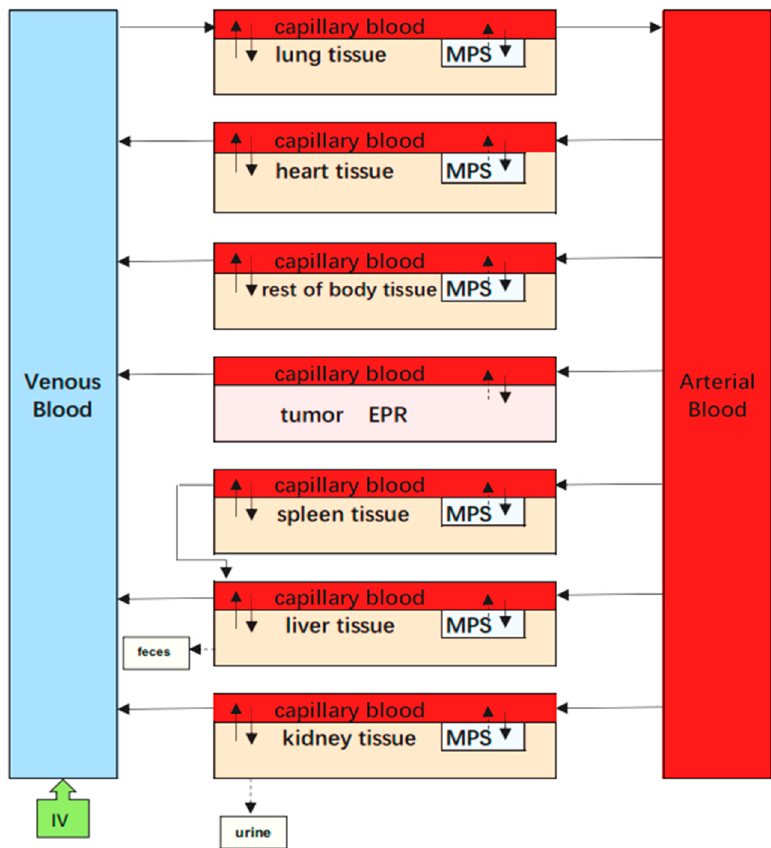
Figure 19. Schematic diagrams illustrating the PBPK model for mPEG-PCL NPs, including mononu- clear phagocytic system in organs represented as “MPS” and enhanced permeability and retention in tumours represented as “EPR.” Arrows indicate the direction of transport of mPEG-PCL NPs, while grey boxes indicate the uptake of mPEG-PCL NPs by MPS or EPR from blood circulation or tissues.